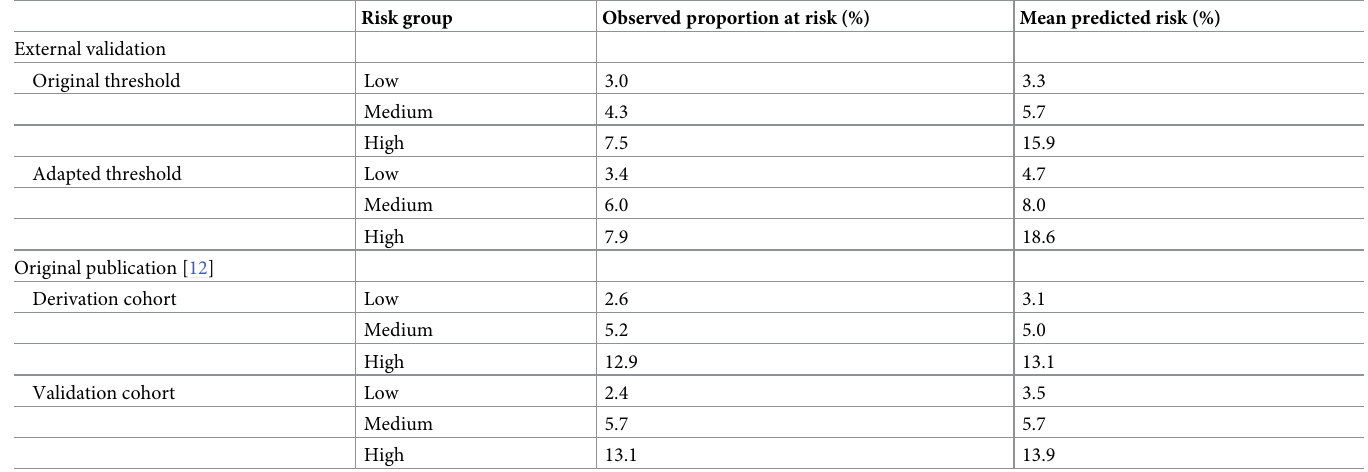
Table 5. Observed versus predicted risk for potentially avoidable readmission